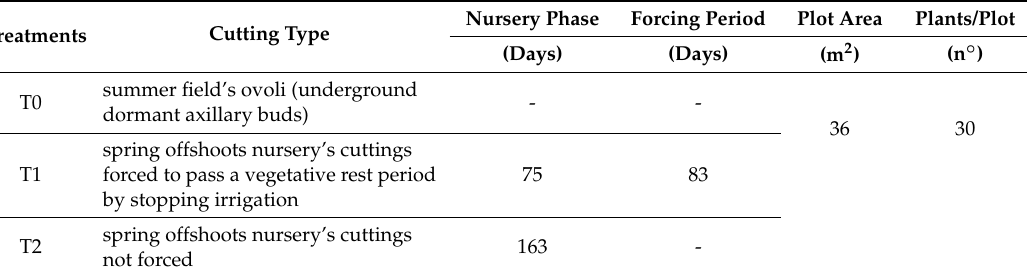
Table 8. Treatment overview and plot characteristics in the